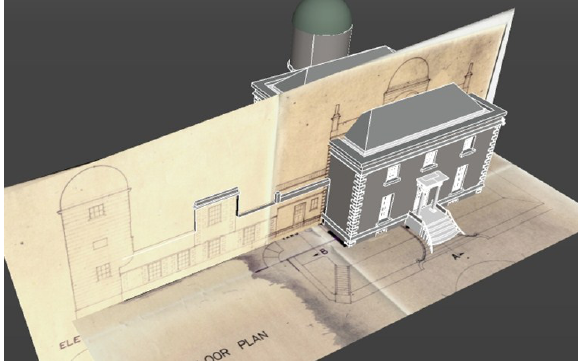
Figure 2: Building extruded from plans and elevations